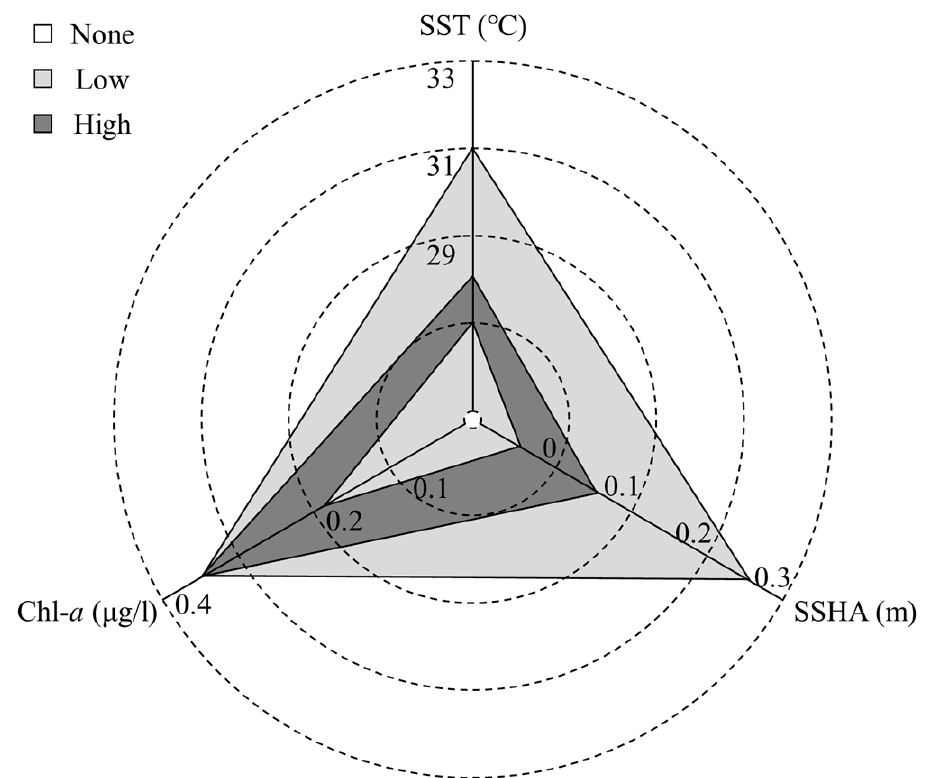
Figure 10. Relationship between CPUE and environmental factors. “High” and “low” CPUE are de- fined according to the CPUE conditions of each environment combined with GAM model results .